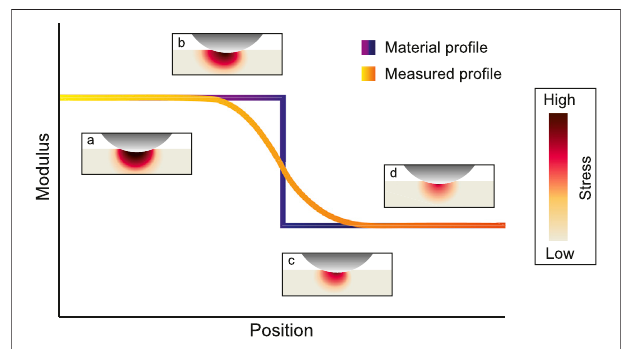
FIGURE 1 | Schematic representation of a material that has a step-wise modulus pro fi le and the resulting modulus pro fi le measured by an indentation experiment at several positions across the modulus interface. The four insets a-ddisplaytheheterogeneousstresspro fi lesinthematerial,colorcoded for the stress, as the material is indented with, in this example, a spherical